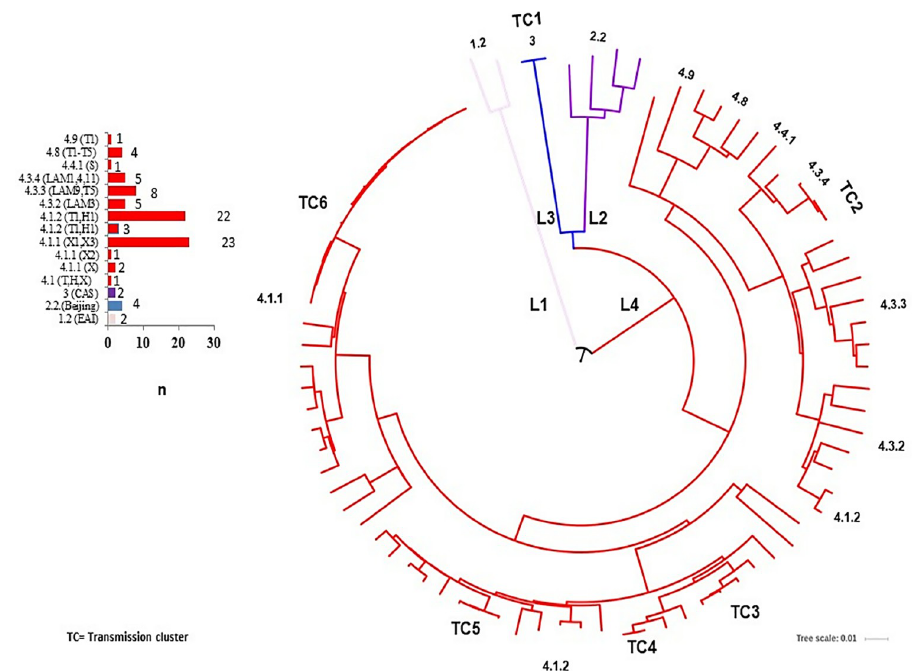
Fig 1. Phylogeny and transmission clusters of M . tuberculosis isolates from Veracruz, Mexico obtained by WGS.